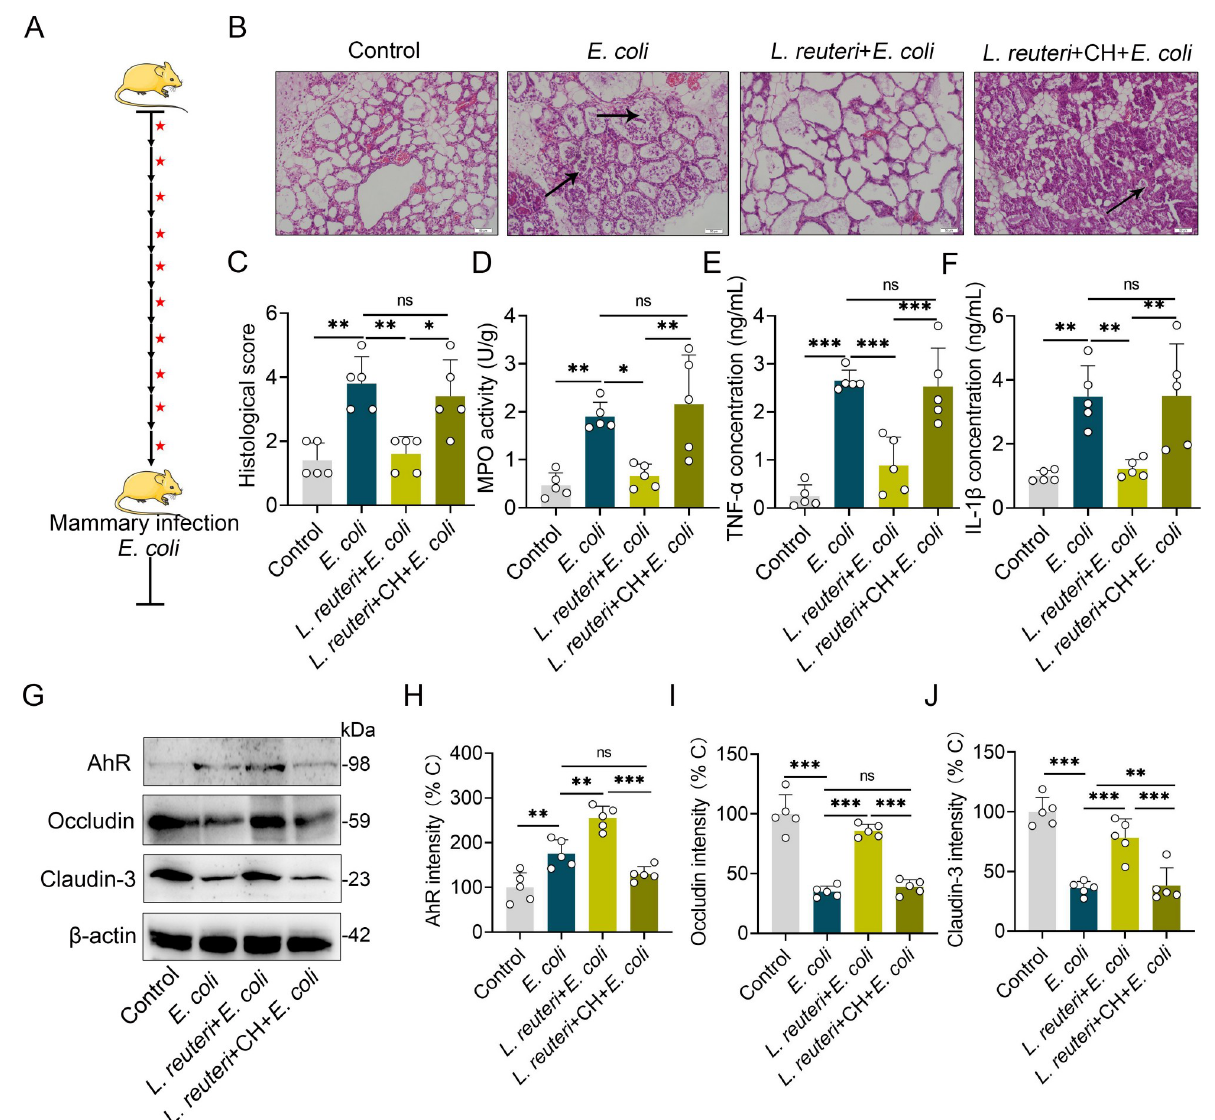
Fig 7. Lactobacillus reuteri ( L . reuteri ) ameliorates E . coli -induced mastitis by activating AhR. (A) Schematic representation of L . reuteri treatment. Black arrows indicate that the mice were given 10 9 CFU/300 μ L L . reuteri by oral gavage once every two days for 21 days. Red stars indicates CH223191 treatment (10 μ g/mouse intraperitoneally) after each L . reuteri gavage. The mastitis model was induced by E . coli (10 7 CFU/ 50 μ L by intra-breast injection) at 21 days. (B ) Representative H&E-staining of mammary gland tissue sections used in histological analysis. The black arrow indicates inflammatory cell infiltration (scale bar, 50 μ m). ( C) Histological score based on H&E stained sections (n = 5). ( D) MPO activity in mammary gland tissues of different treated mice (n = 5). Inflammatory markers of TNF- α ( E ) and IL-1 β ( F ) from different groups (n = 5). AhR, occludin and claudin-3 protein levels ( G ) and intensity analysis based on G (n = 5) ( H-J ). The data are presented as the means ± SEM (C–F and H-J). ns, no significance, � p < 0.05, �� p < 0.05, and ��� p < 0.001 indicate statistical significance by one-way analysis of variance. L . reuteri , Lactobacillus reuteri ; CH,